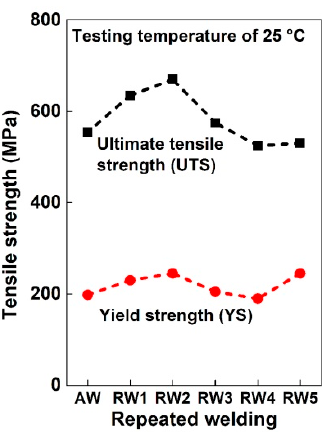
Figure 14. Ultimate tensile strength and yield strength of the AW, RW1–RW5 specimens by welding and repeated welding in the Gleeble weld-simulator at room